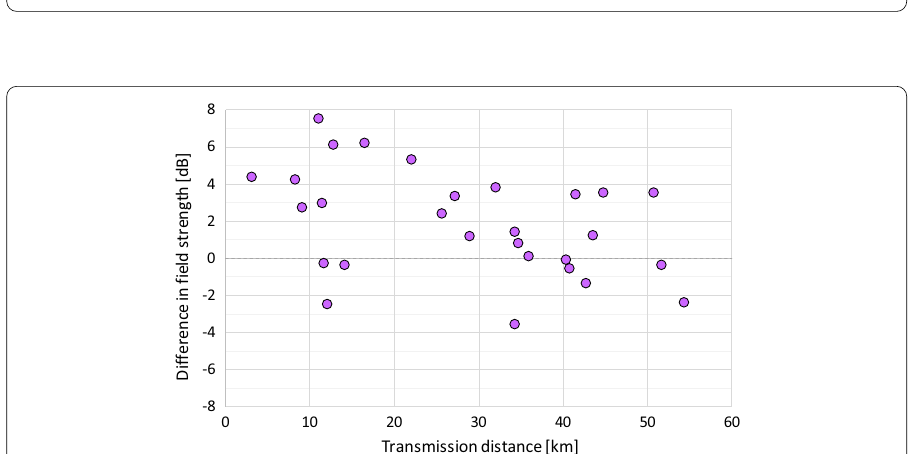
Fig. 14 Difference in field strength between horizontal and vertical polarization (vertical minus horizontal) in field